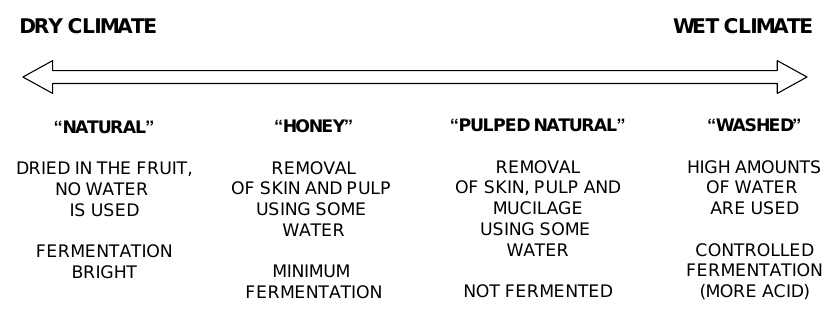
Figure 2. Coffee cherry processing methods used according to regional climatic characteristics.